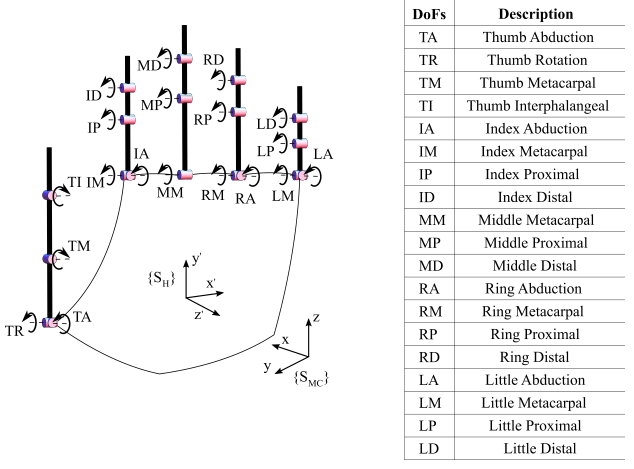
Figure 3. The 19 degrees of freedom (DOF) kinematic model of the human